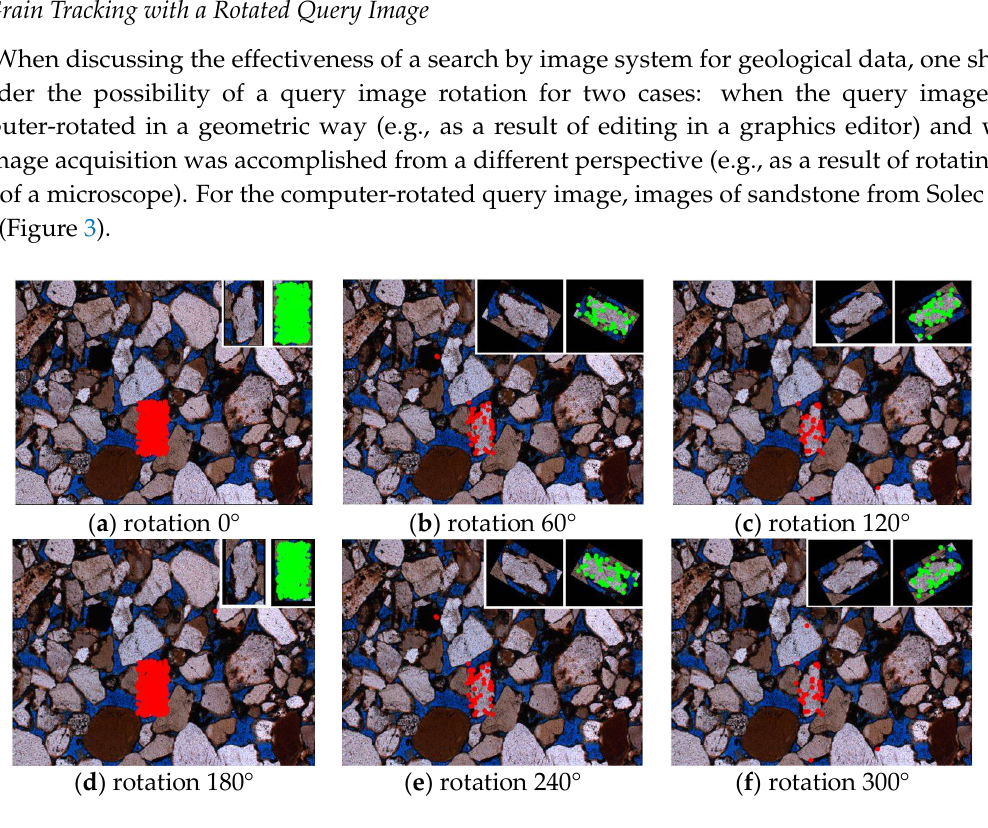
Figure 3. Effects of the detection of interest points between computer-rotated query (green points) and original image (red points) obtained for the SURF method, sandstone from Solec.